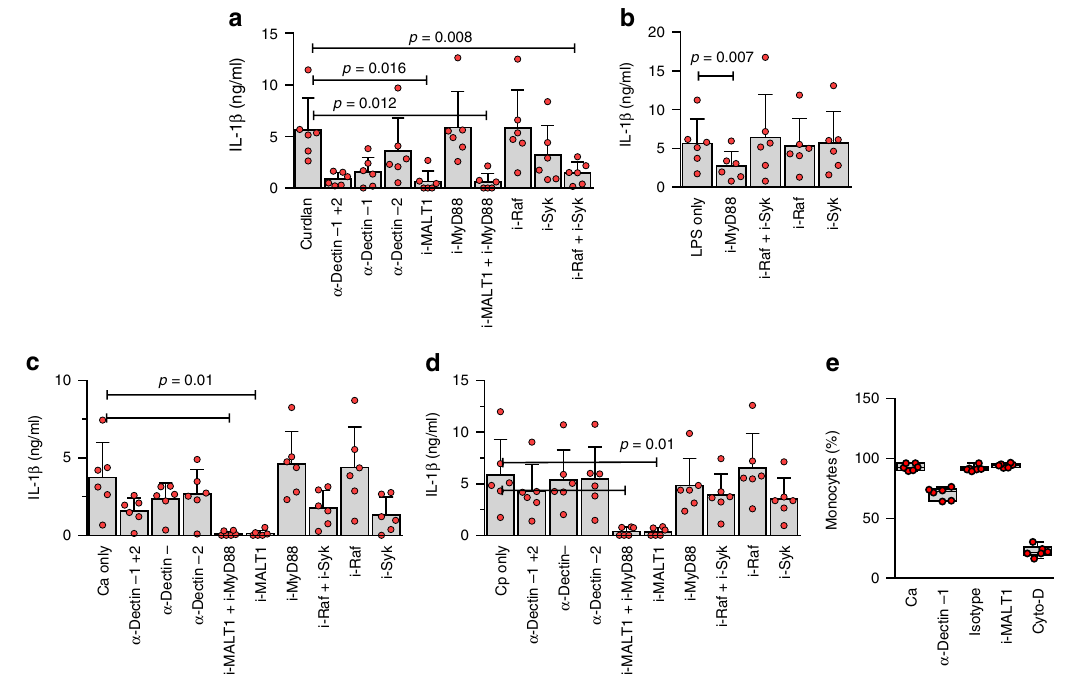
Fig. 6 MALT1 is essential for Candida recognition and curdlan signaling in human monocytes. IL-1 β production after stimulation (24 h) with a curdlan or b LPS, or with c C. albicans or d C. parapsilosis , and upon inhibition (i) of MALT1 (using mepazine hydrochloride), MyD88 (ST2825), Raf (GW5074) or Syk (Piceatannol), or blocking of dectin-1 or dectin-2 using antibodies (data pooled from 6 experiments (6 subjects); mean ± SD); e Effect of MALT1 inhibition, dectin-1-blocking antibody or actin polymerization inhibition (using cytochalasin- D ) on phagocytosis of Candida by monocytes (boxes and whiskers; data also from 6 experiments). Statistical signi fi cance was calculated using 2-sided paired t